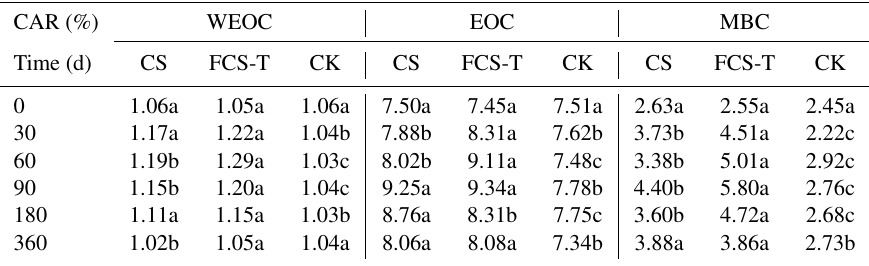
Table 3. The carbon-available ratio (CAR) of water-extractable organic carbon (WEOC), easily oxidizable organic carbon (EOC), and microbial biomass carbon (MBC) under different treatments in the 0–360d period. Note that values are means that do not share the same letter for a given parameter, and time (d) of experiments is significantly different ( P < 0 . 05). CS, corn straw returned to the field; FCS-T, fermented corn straw treated with T. reesei returned to the field; CK, blank control treatment. CAR (%) WEOC